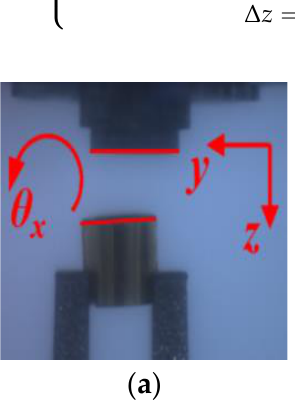
Figure 18. Parts ’ pose calibration of CCD. ( a ) Front view of sleeve after posture adjustment; ( b ) Left side view of sleeve after posture adjustment.